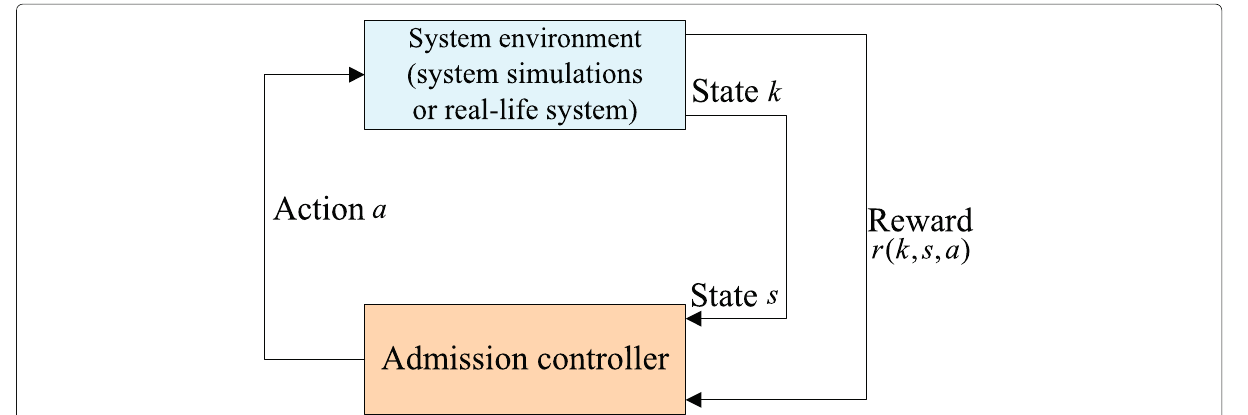
Fig. 5 Reinforcement learning model. This figure illustrates the RL model used in the proposed task admission control policy algorithm, which learns through interacting with the system